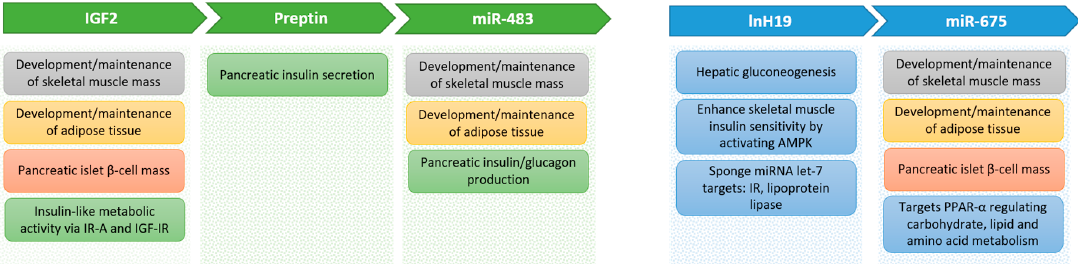
Figure 2. Metabolic effects of components of the Ins/Igf2/H19 cluster genes.